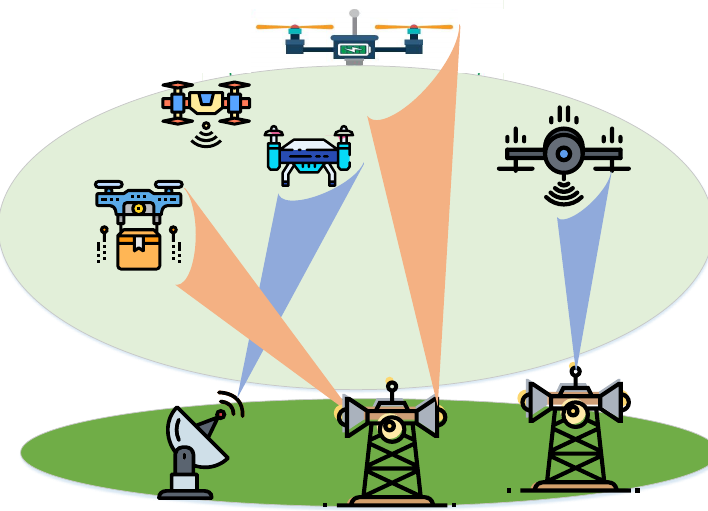
Figure 15. Laser beaming for UAV charging.